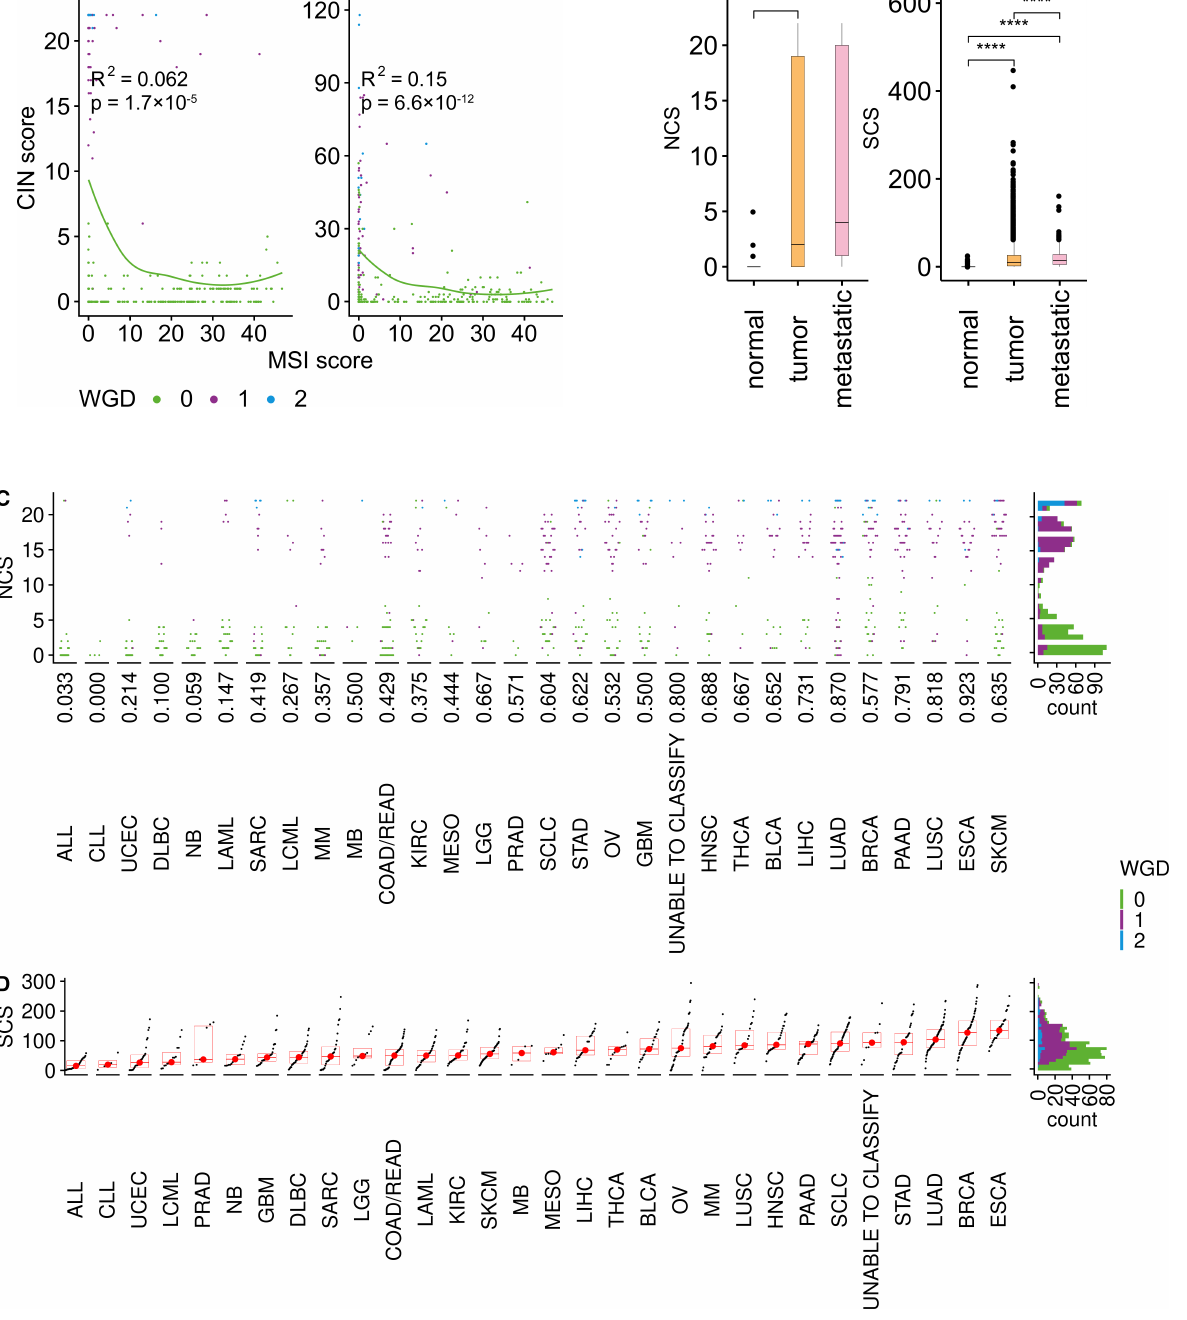
Figure A2. ( A ) The relationship between microsatellite instability (MIN) scores and the NCS and the SCS. ( B ) Comparison of the NCS and the SCS between normal samples with primary and metastatic tumour samples. ( C ) Cancer type-wise NCS distribution in CCLE cell lines, cancer types are ordered by the median NCS; whole genome doubling (WGD) status is encoded by colours. The number reported on x axis is the proportion of samples that underwent WGD. ( D ) SCS distribution in CCLE cell lines, cancer types are ordered by their median